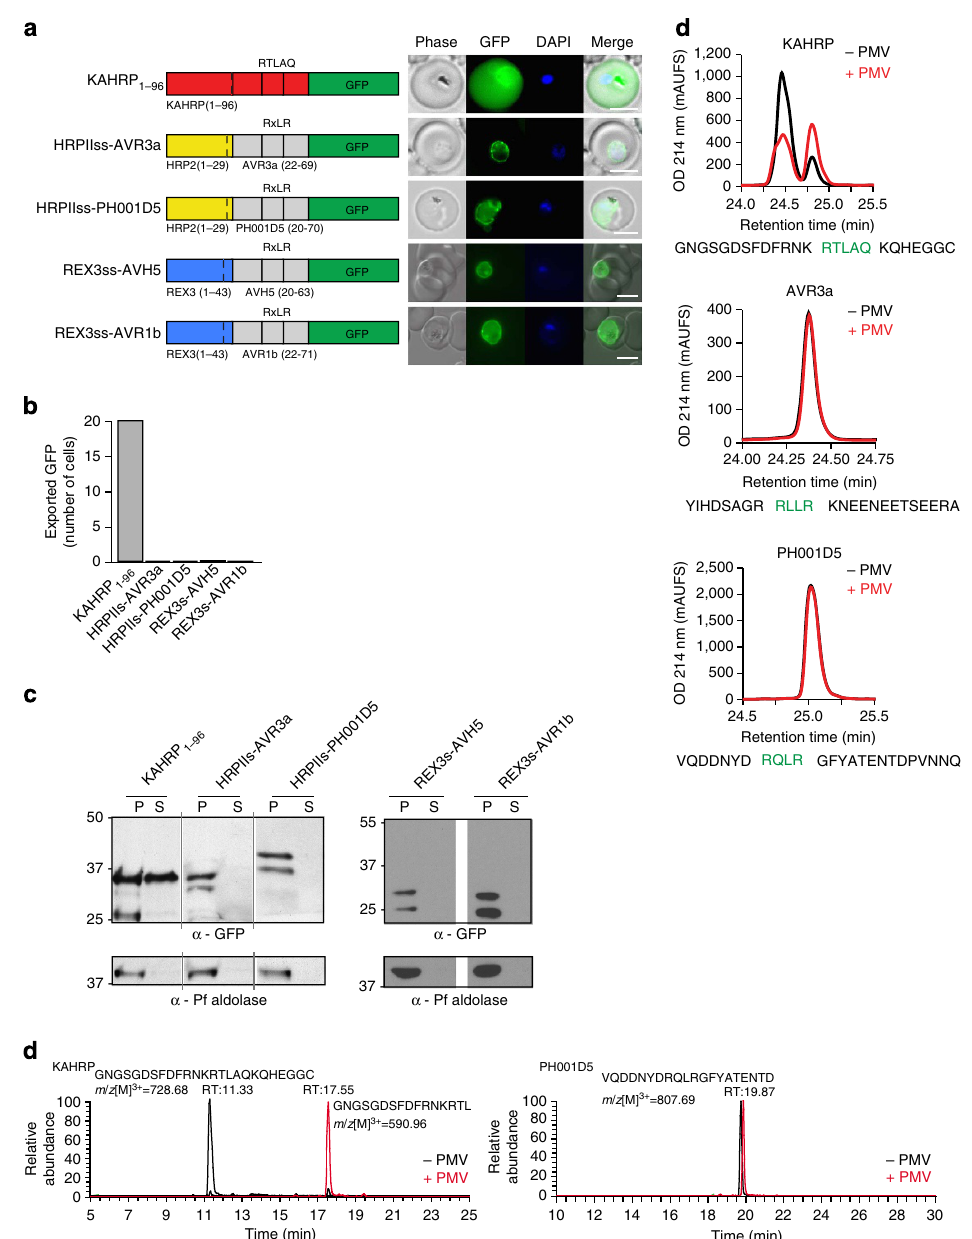
Figure 3 | Oomycete RxLR does not mediate export in P. falciparum . ( a ) KAHRP 1–96 is exported to the P. falciparum -infected erythrocyte; however, HRPIIss-AVR3a, HRPIIss-PH001D5, REX3ss-AVH5 and REX3ss-AVR1b are not exported but accumulate in the parasite and PV. Scale bar, 5 m m. ( b ) Quantification of cells with exported GFP determined using 20 P . falciparum -infected erythrocytes per construct (10 cells per experiment, performed twice). ( c ) Immunoblot with anti-GFP antibodies of each chimera from the tetanolysin pellet (P) and supernatant (S) shows that KAHRP 1–96 is exported but RxLR chimeras are not. Tetanolysin inserts pores in the erythrocyte membrane, allowing sampling of the host cell cytosol. Aldolase was included as a control, as described previously 71 . Full-length gels shown in Supplementary Fig. 8. ( d ) RP-HPLC shows the KAHRP peptide is cleaved when incubated with PMV (red). AVR3a and PH001D5 peptides are not cleaved by PMV. PEXEL/RxLR sequences are labelled green. ( e ) MS/MS-extracted ion chromatograms of KAHRP and PH001D5 peptides after incubation with PMVshows that KAHRP peptides were cleaved after the PEXEL Leu (GNGSGDSFDFRNKRTL (cid:2) ) but PH001D5 was not